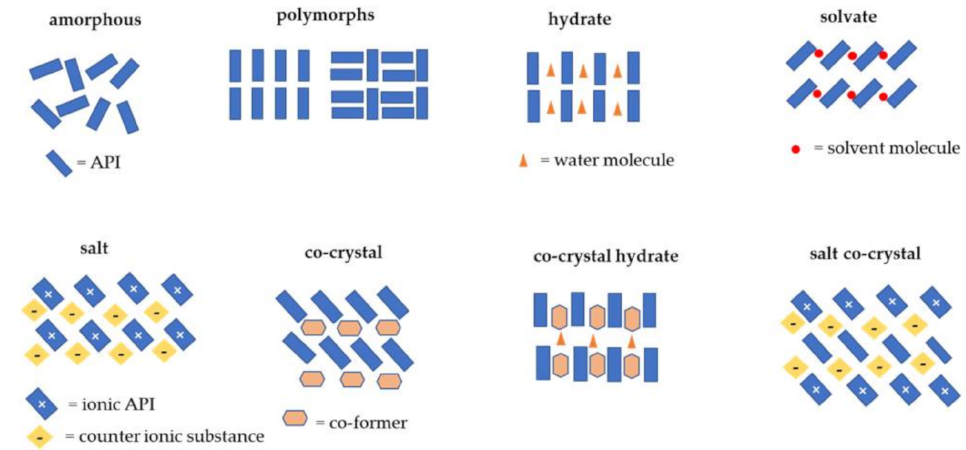
Figure 1. Illustration of the difference between co-crystal and other solid forms